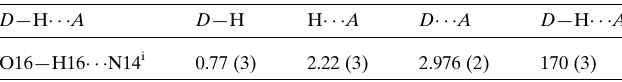
Table 1 Hydrogen-bond geometry (A˚ , (cid:4)